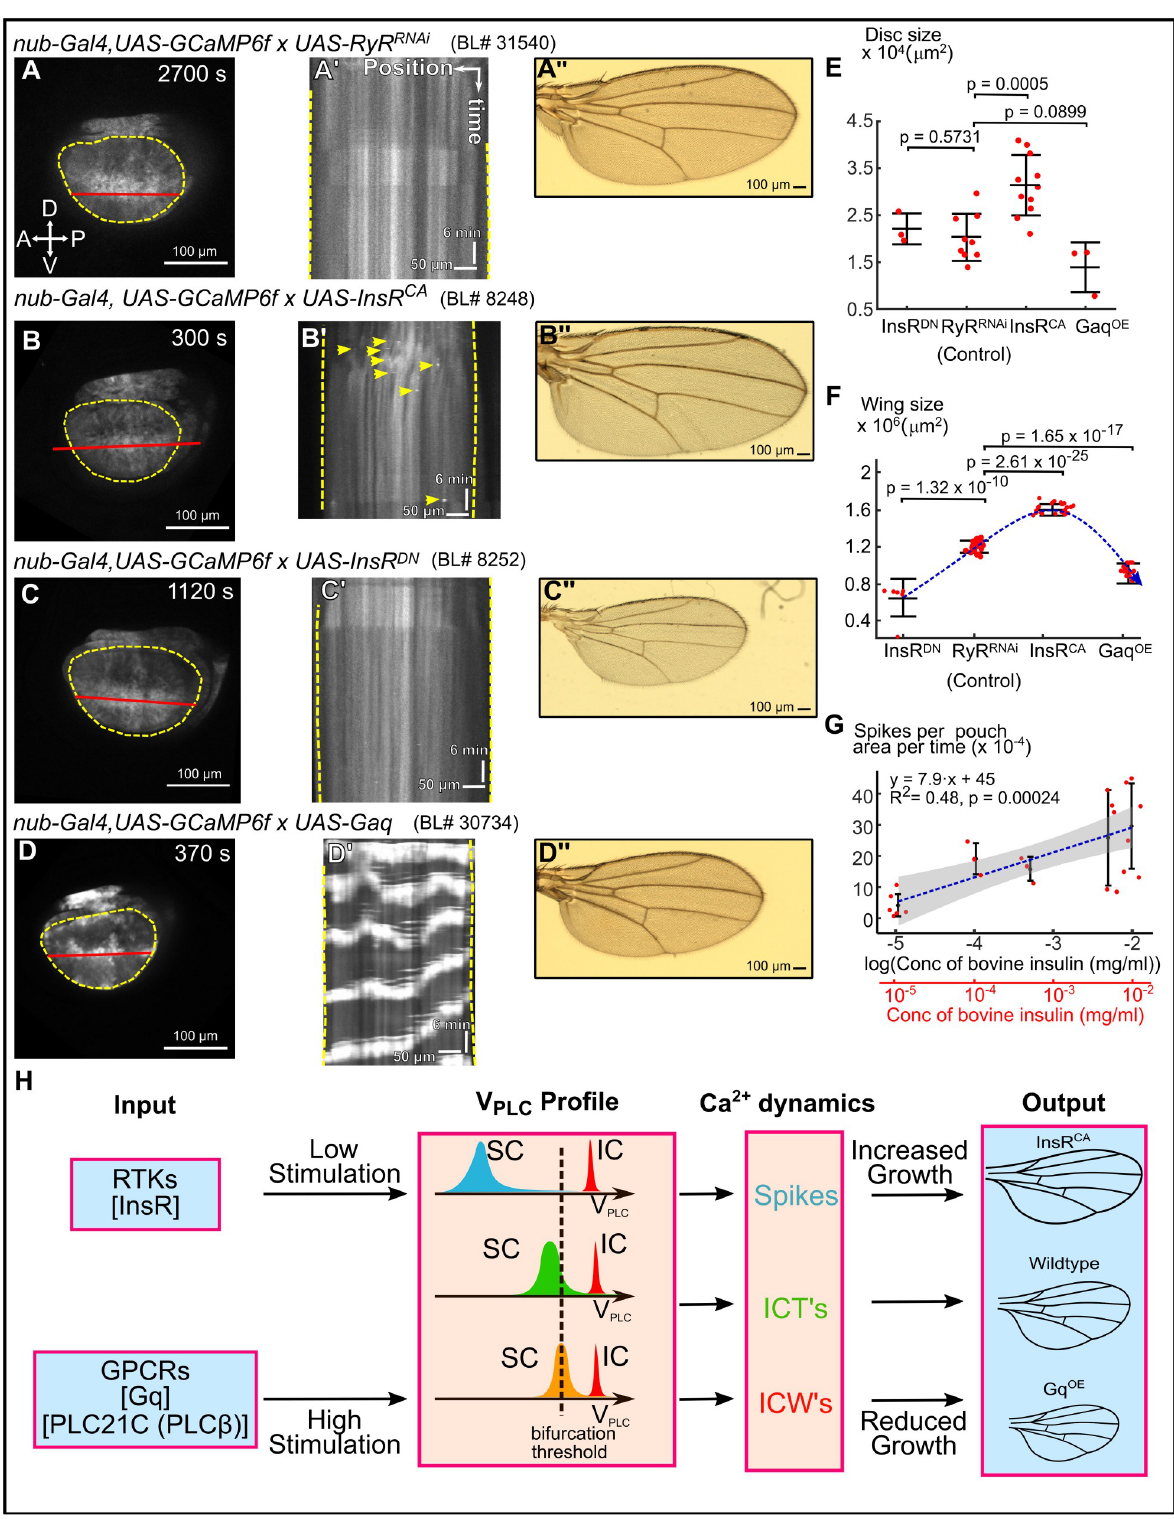
Fig 5. GPCR and insulin signaling regulate wing size and differentially regulate Ca 2+ signaling. (A-D) Montages of time-lapse movies of wing discs cultured ex vivo. (A’-D’) Kymographs of the corresponding time-lapse movies. (A"-D") Adult wings from the indicated genetic perturbation. (E) Quantification of the wing disc sizes for the indicated genetic perturbations. (F) Quantification of the adult wing sizes for the